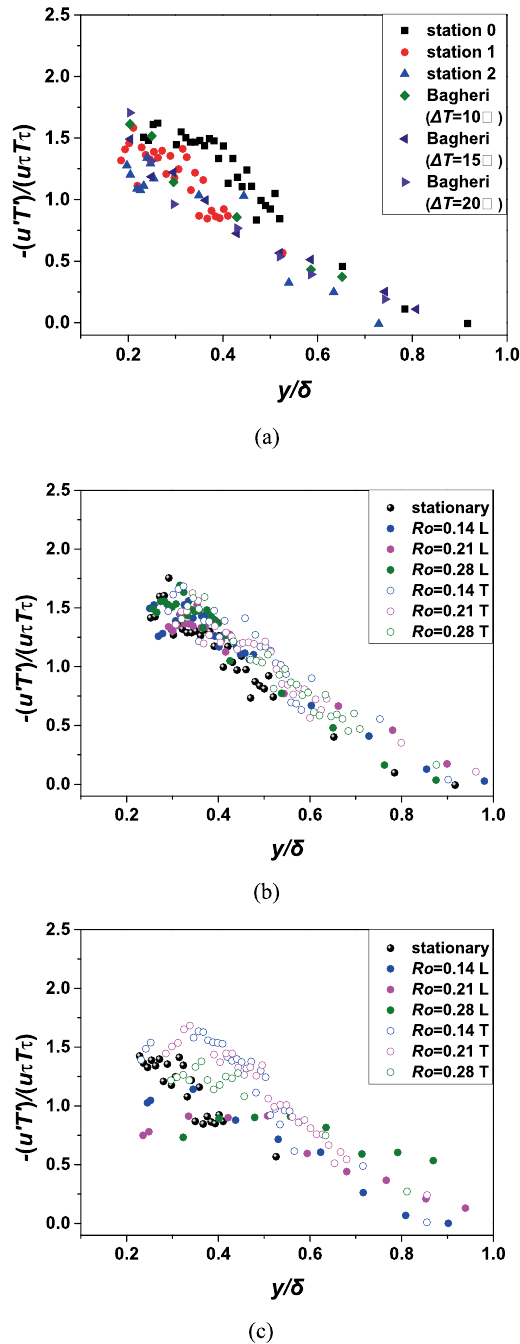
Figure 11. Contrast with the research of Bagheri 16 ( a ) and streamwise turbulent heat flux profiles under different rotation numbers at location 0 and location 1 ( b,c